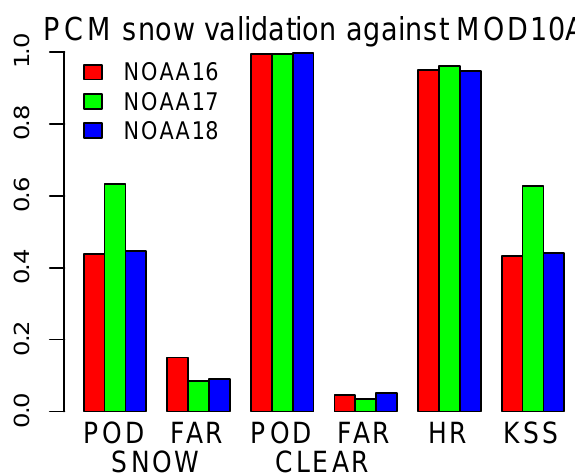
Fig. 14. Accuracy indicators of the PCM snow detection skills de- rived from the comparison with the MOD10A1 product. For details see Sect. 4.2.